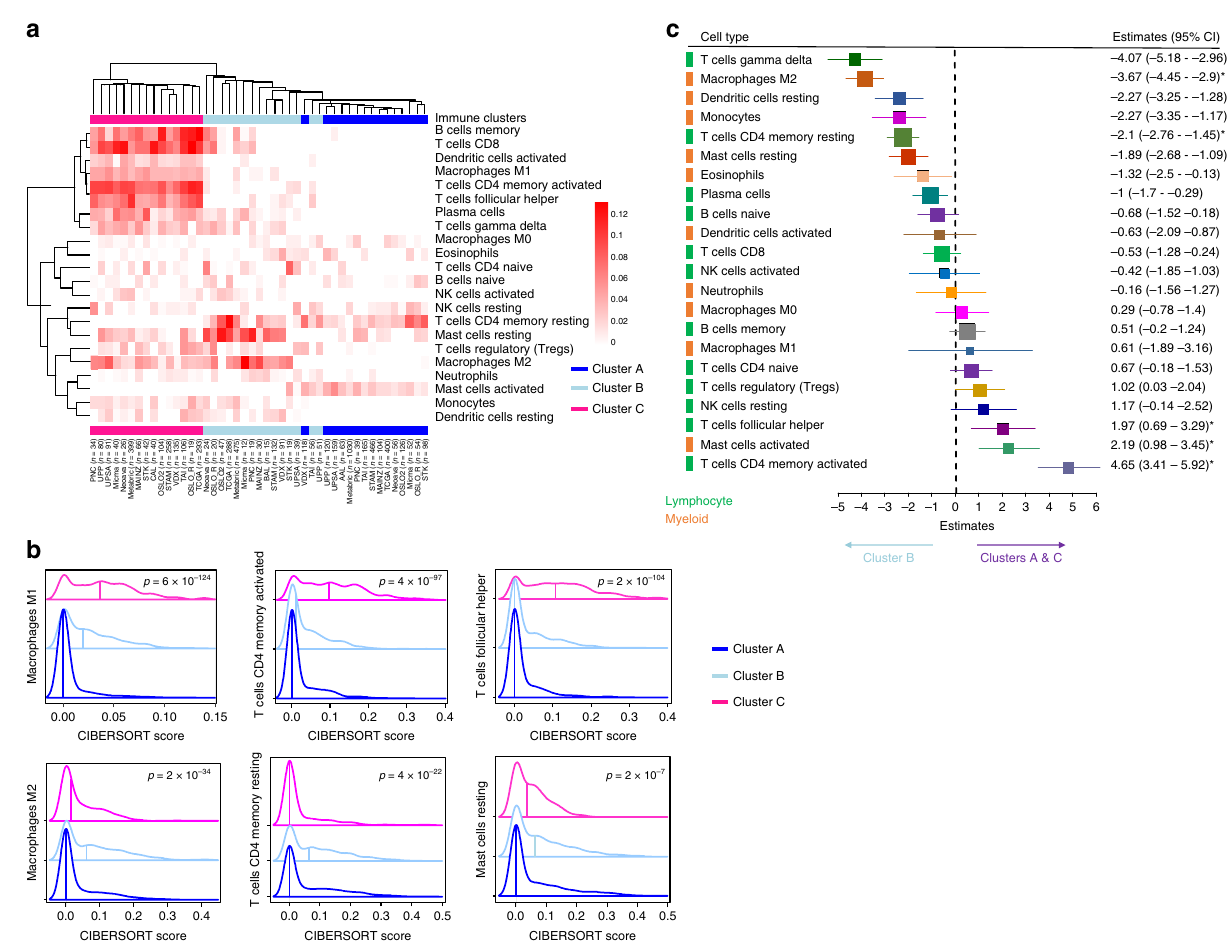
Fig. 5 In silico dissection of the immune clusters. a We used the CIBERSORT algorithm to assess the composition of the immune microenvironment of breast cancer samples. For each cluster, we calculated the median of the absolute score of the 22 cell types given by the CIBERSORT in each cohort. Immune cluster-speci fi c cell-type median scores were used in an unsupervised clustering using maximum linkage and the ward.D2 method. The heatmap obtained allows to visualize which cell types are enriched across the immune clusters. Immune clusters are annotated on the top and bottom of the heatmap. b Density plots represents the distribution of the absolute CIBERSORT scores for selected cell types across the clusters for the METABRIC cohort; the vertical lines crossing the distribution identify the median value for the score. Kruskal – Wallis test p value are denoted. c Estimates of multivariable logistic regression analysis and the 95% con fi dence interval (CI) are illustrated by forest plot to assess which immune cells inferred by CIBERSORT explain the most the poor prognosis cluster (Cluster B) vs Clusters A and C. Box size is inversely proportional to the width of the con fi dence interval. Asterisks denote FDR-corrected p value < 0.05. Immune cell types from the lymphoid or myeloid lineage are identi fi